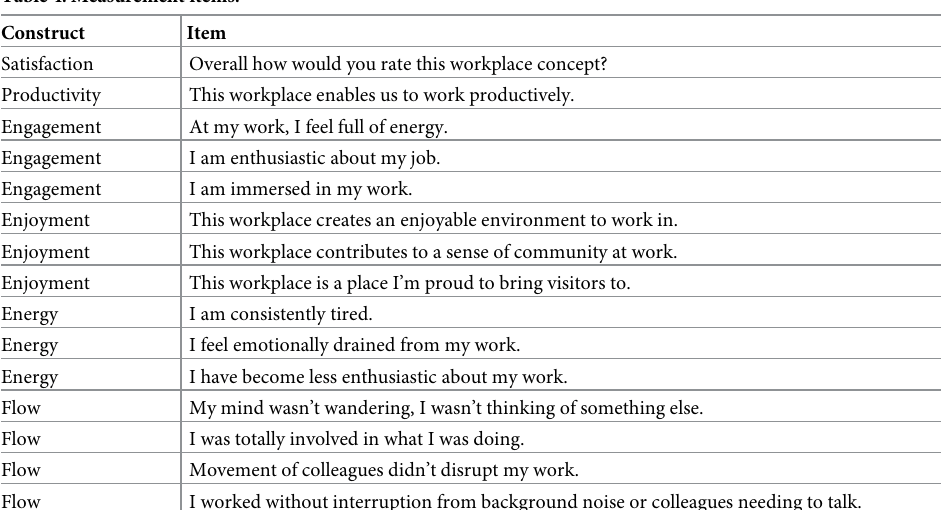
Table 4. Measurement